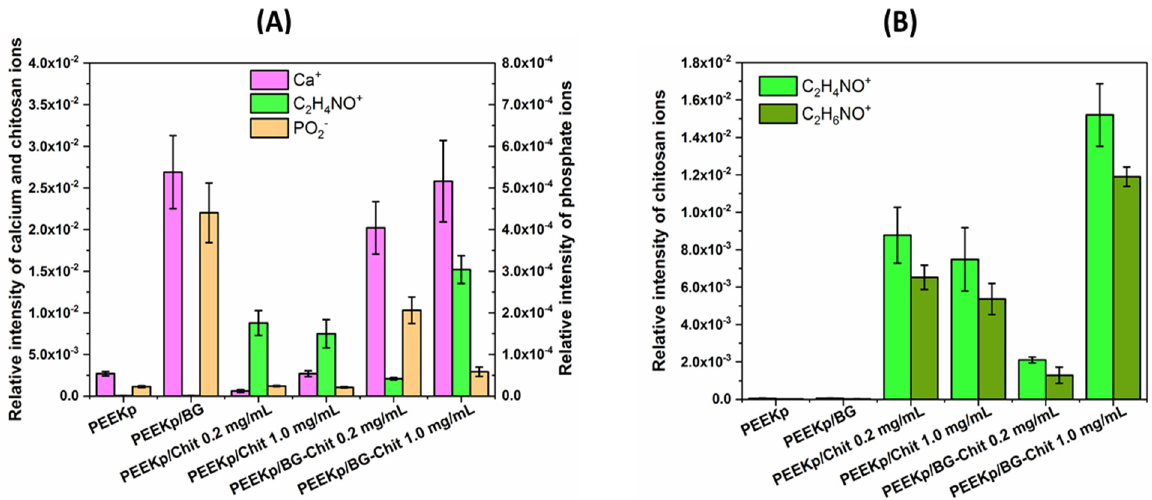
Figure 3. ( A ). Relative intensities of calcium ( 𝐶𝑎 (cid:2878) ), phosphate ( 𝑃𝑂 (cid:2870)(cid:2879) ), and chitosan ( 𝐶 (cid:2870) 𝐻 (cid:2872) 𝑁𝑂 (cid:2878) ) ions determined on the modified PEEK surfaces. ( B ). Relative intensities of chitosan ( 𝐶 (cid:2870) 𝐻 (cid:2872) 𝑁𝑂 (cid:2878) and 𝐶 (cid:2870) 𝐻 (cid:2874) 𝑁𝑂 (cid:2878) ) characteristic ions determined on the modified PEEK surfaces.